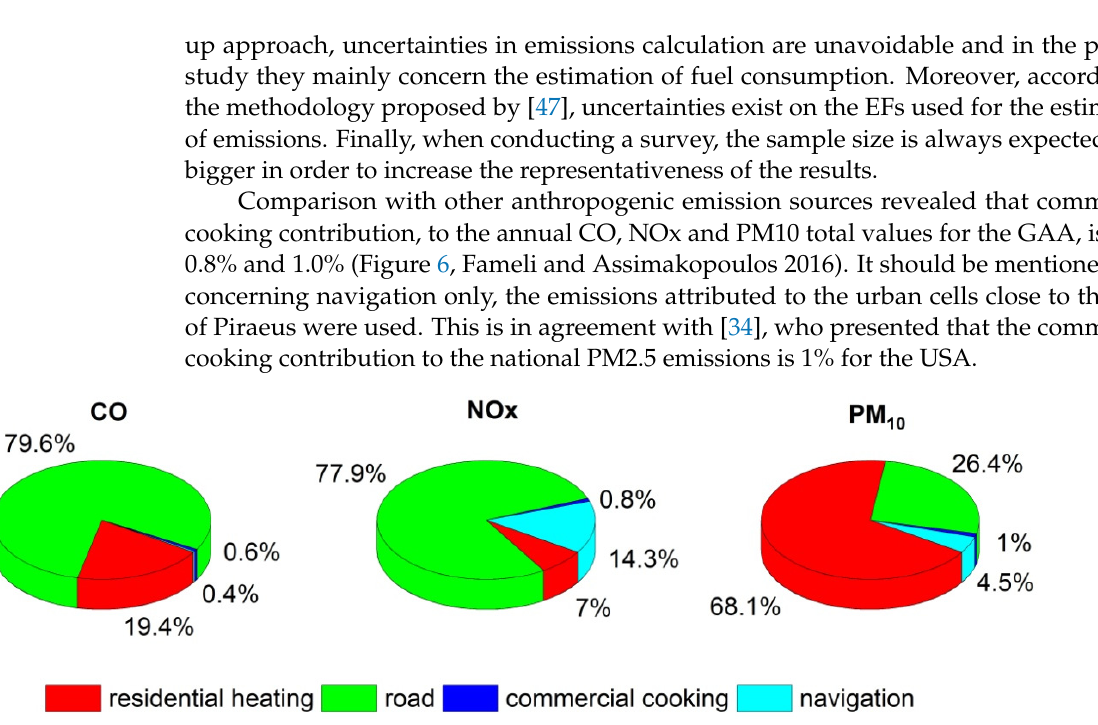
Figure 6. Percentage contribution of different sources (residential heating, road transport, commercial cooking and navigation) to the total emissions at the GAA.